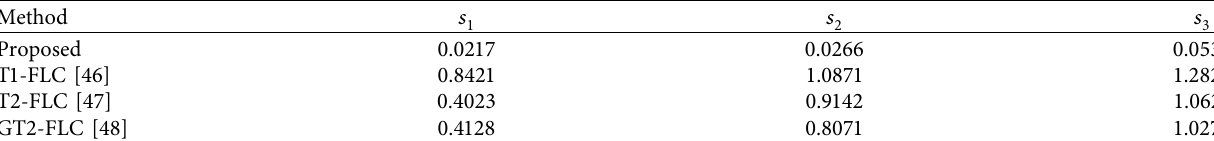
Figure 19: Scenario 6.3: a phase portrait. Table 2: RMSE